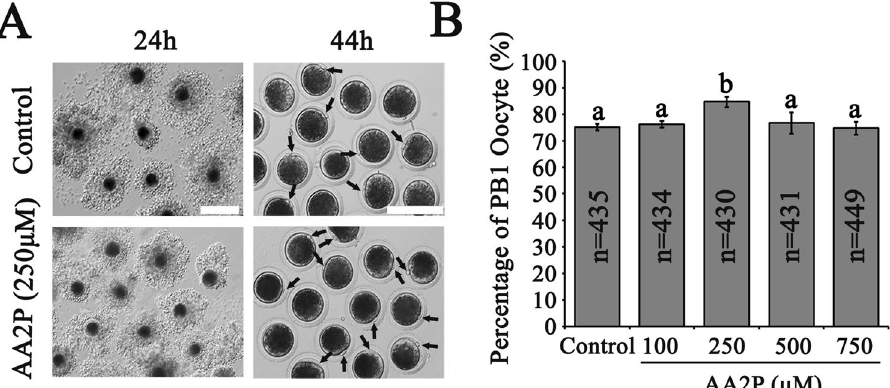
Figure 1. AA2P promotes the nuclear maturation of pig oocytes. ( A ) Representative images of porcine COCs in vitro matured for 24 h (left column) and denuded oocytes from in vitro matured COCs for 44 h (right column). Images in the left column showed cumulus extension with no differences among control and 250 µ M AA2P treated groups, and ones in right column showed the morphology of oocytes after 250 µ M AA2P treated for 44 h during IVM. Scale bar: 200 µ m. ( B ) 250 µ M AA2P treatment significantly increased the polar body 1 (PB1) extrusion rate of porcine oocytes. Different lowercase letters a and b indicate significant differences at P < 0.05